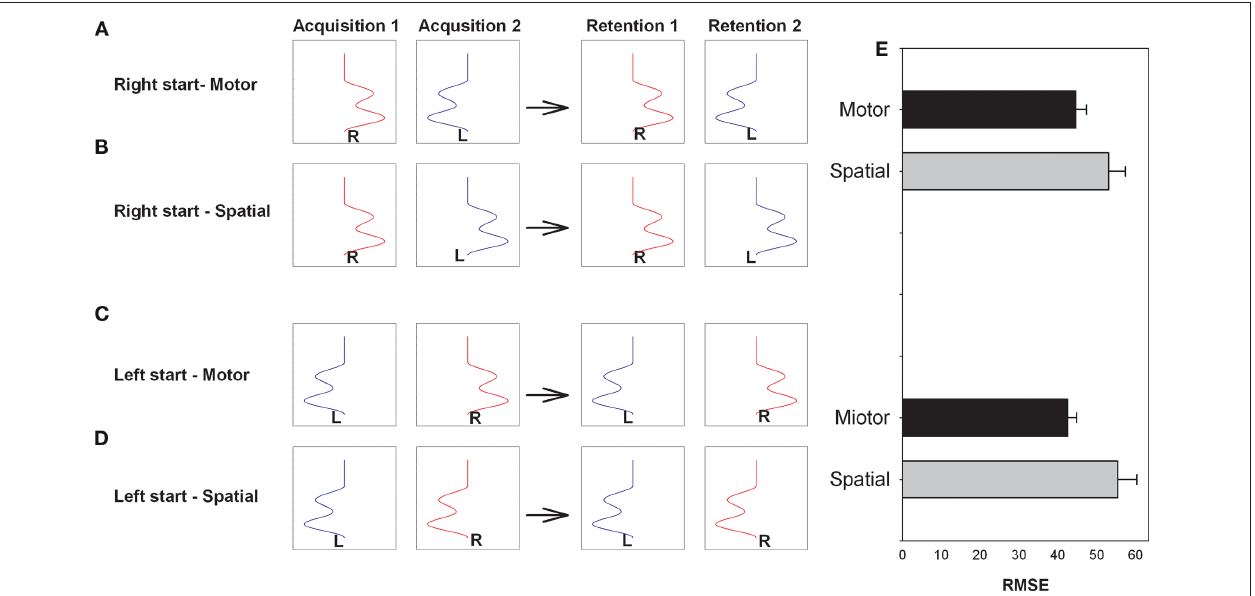
Figure 4 | illustration of the arm and task used on acquisition sessions (1 and 2) and retention tests (1 and 2) for the right start group with the same motor coordinates on the two acquisition session (A) and right start group with the same spatial coordinates on the two acquisition sessions (B). Left start group with the same motor coordinates (C) and same spatial coordinates (D) are also illustrated. Retention performance is for each condition is provided to the right (e) . Note that this design does not require effector transfer test to determine the coordinate system used to code the movement sequence (Redrawn from Panzer et al,